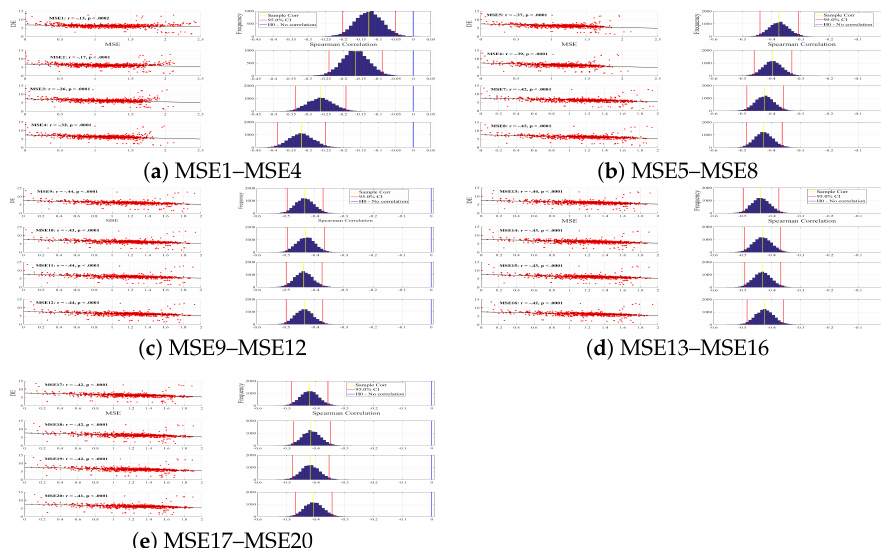
Figure A8. Neutral mental state. Spearman correlation between participants’ DEs (i.e., 62 DEs associated with 62 EEG channels of a participant, per affect) and their corresponding MSE1s (i.e., 62 MSE1s associated with 62 EEG channels of a participant, per affect) through MSE20 values (i.e., 62 MSE20s associated with 62 EEG channels of a participant, per affect). The subplots in the right column correspond to bootstrap correlation test (10,000 simulation runs) at 95.0% confidence interval. The values associated with these subplots are summarized in Table